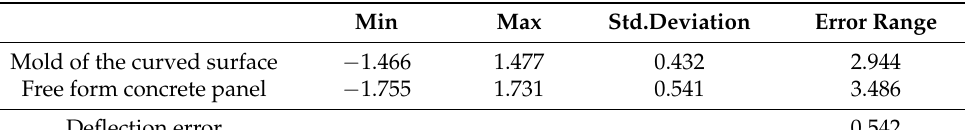
Table 5. Deflection error caused by the load of